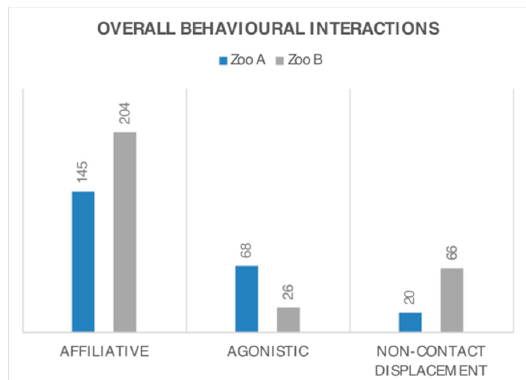
Figure 2. Comparison of overall interaction counts between zoos. Sum of interactions (adjusted strength) per social interaction category observed in each zoo across both time points, representing 10 h of observation per individual ( n = 4 per zoo).